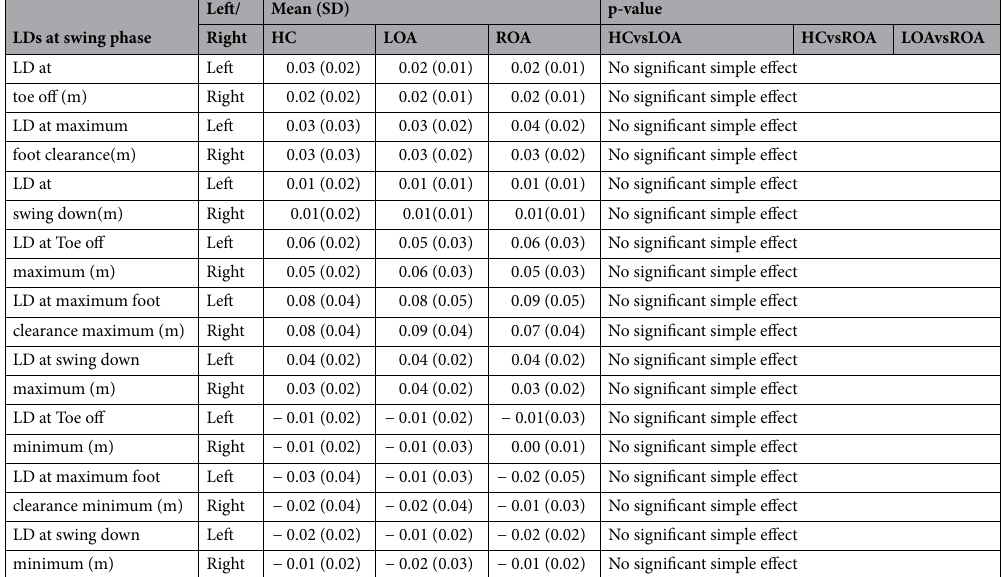
Table 3. The result of multiple comparison tests for the group. For the lateral distance (LD) at swing phase other than the toe off maximum, toe off minimum and swing down minimum, significant interactions were found. Means and (standard deviations) of LDs at swing phase. Healthy control (HC), left hip osteoarthritis (LOA), right hip osteoarthritis